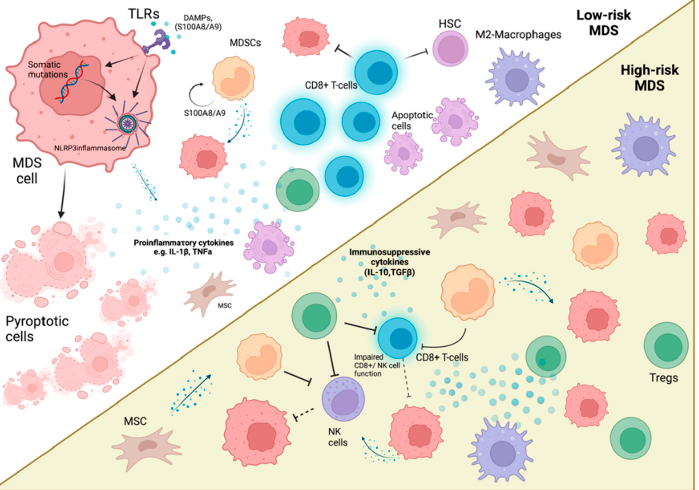
Figure 1. The immune landscape in low (top half) and high-risk (bottom half) MDS. NLRP3 inflam- masome recruitment (by means of TLR signaling pathways (through DAMPs, PAMPs, S100A8/A9) and somatic mutations) by cancer cells is central in MDS pathogenesis driving proinflammatory cytokine production and pyroptosis. In low-risk disease, cytotoxic T-lymphocytes are increased, whereas Tregs are reduced. Cytotoxic T-cells suppress both malignant and normal HSCs further augmenting the cytopenic phenotype. High-risk disease is characterized by MDS clone expansion driven by immunosuppressive cytokine production, reduced efficiency of NK cells, and cytotoxic T-cells with concomitant expansion of Tregs and MDSCs. MSCs and M2-phenotype mac.